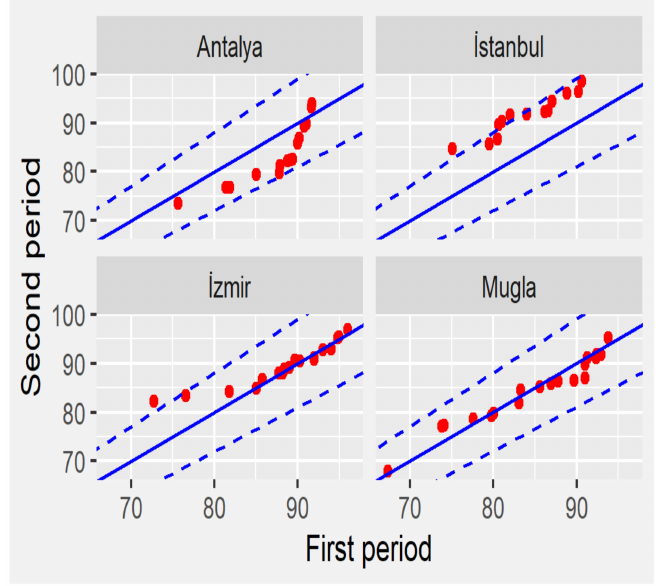
Figure 10. Sen trend analysis of TCI of